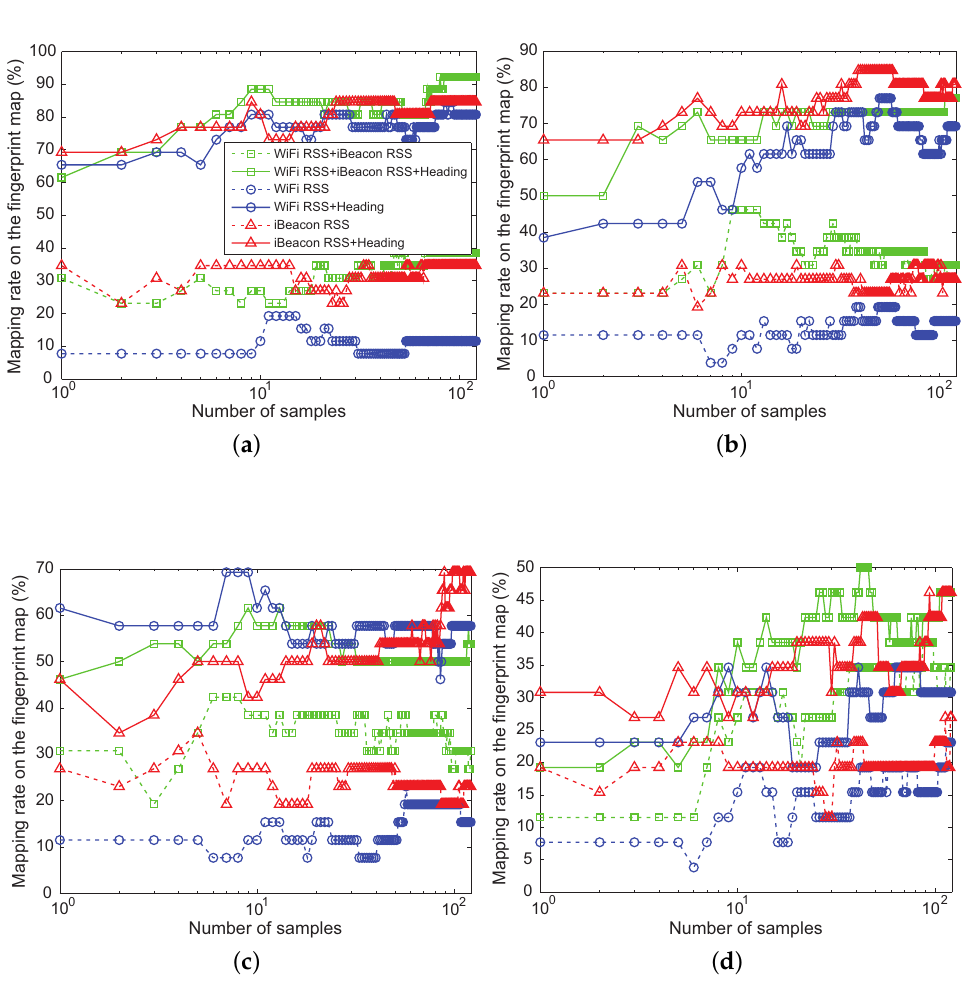
Figure 9. Mapping rate of: ( a ) NBC; ( b ) KNN; ( c ) ANN; and ( d ) SVM in Scenario S1 with good wireless signal